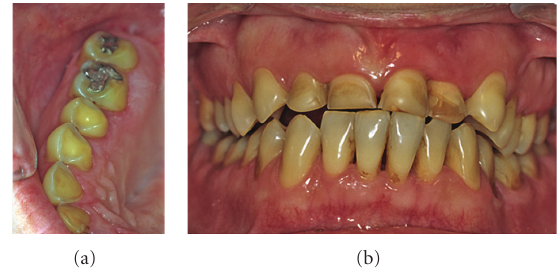
Figure 5: A 40-year-old woman who had su ff ered from Bulimia Nervosa since she was a teenager. Frequent vomiting followed by intense and meticulous toothbrushing in combination with a high intake of light cola-type soft drinks have resulted in severe erosive tooth wear. A number of “raised” amalgam fillings have developed resulting in an unstable occlusion. At the time that these photographs were taken, she had for a long time been free of her eating disorder but su ff ers a lot from tooth sensitivity [11].